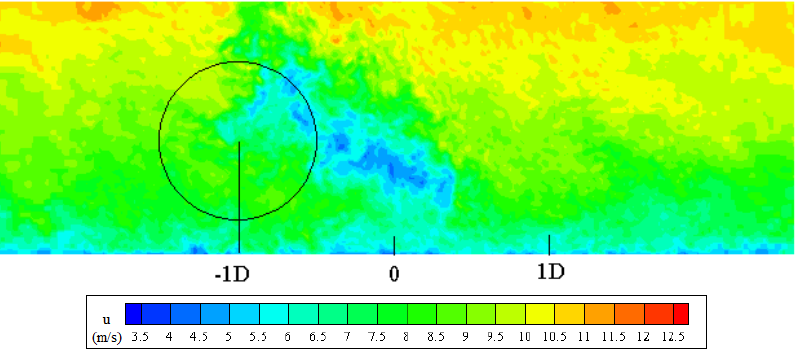
Figure 9. WT2 instantaneous streamwise velocity contours.